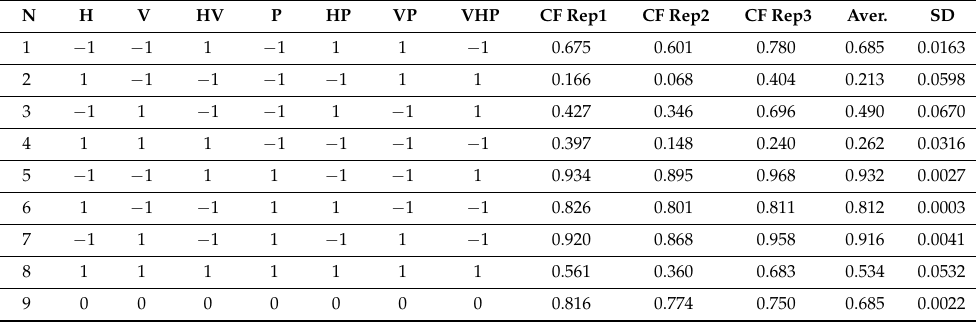
(P = vibration amplitude, V = sweeping speed, and H = gap). Table 5. Absolute reflectance after cleaning [%] for intensively soiled